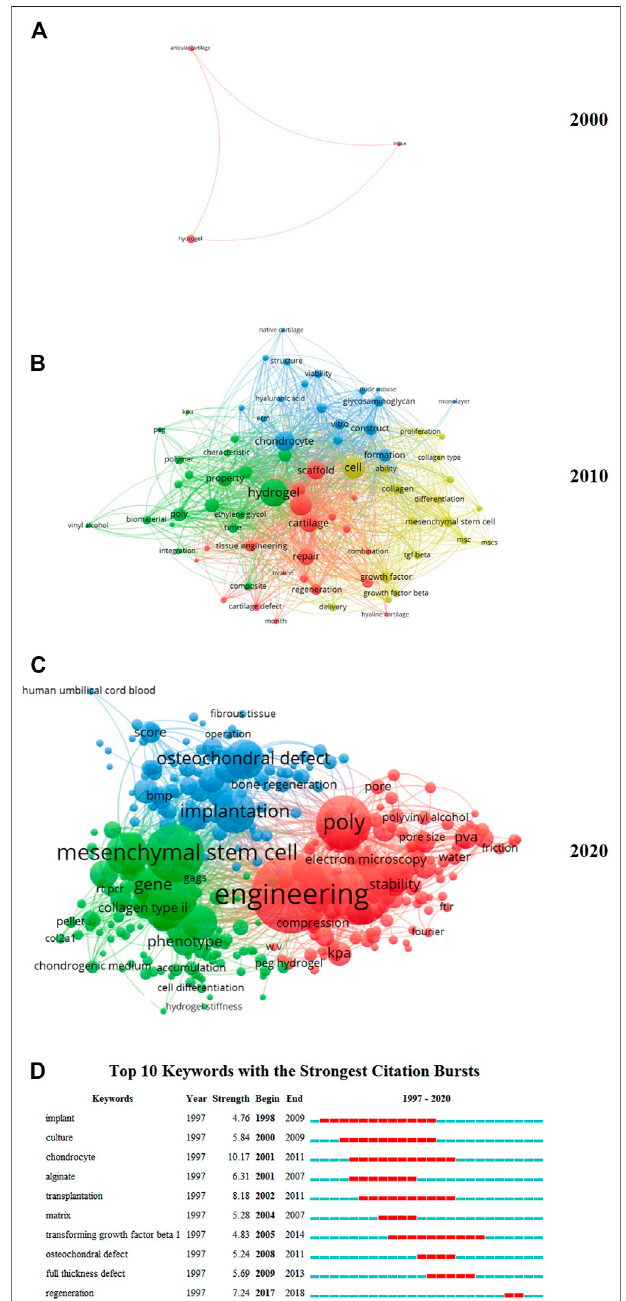
Figure 9 | Co-occurrenceanalysisofresearchesabouthydrogelincartilage repair. (A) Map of keywords of researches about hydrogel in cartilage repair from 1988to2000. (B) map ofresearchesabouthydrogelin cartilagerepair from 1988 to2010. (C) mapofkeywordsisrepresentedbyadotandthesizeofthedot represents the number of publications in this dot. The line between two dotsa showsthecollaborationandco-occurrence.TheLargerthenumberofpublications forwhichtwodotsarebothfound,thestrongertherelationshipbetweenthedots. (D) Burst detections of top 10 keywords with the strongest citation bursts.